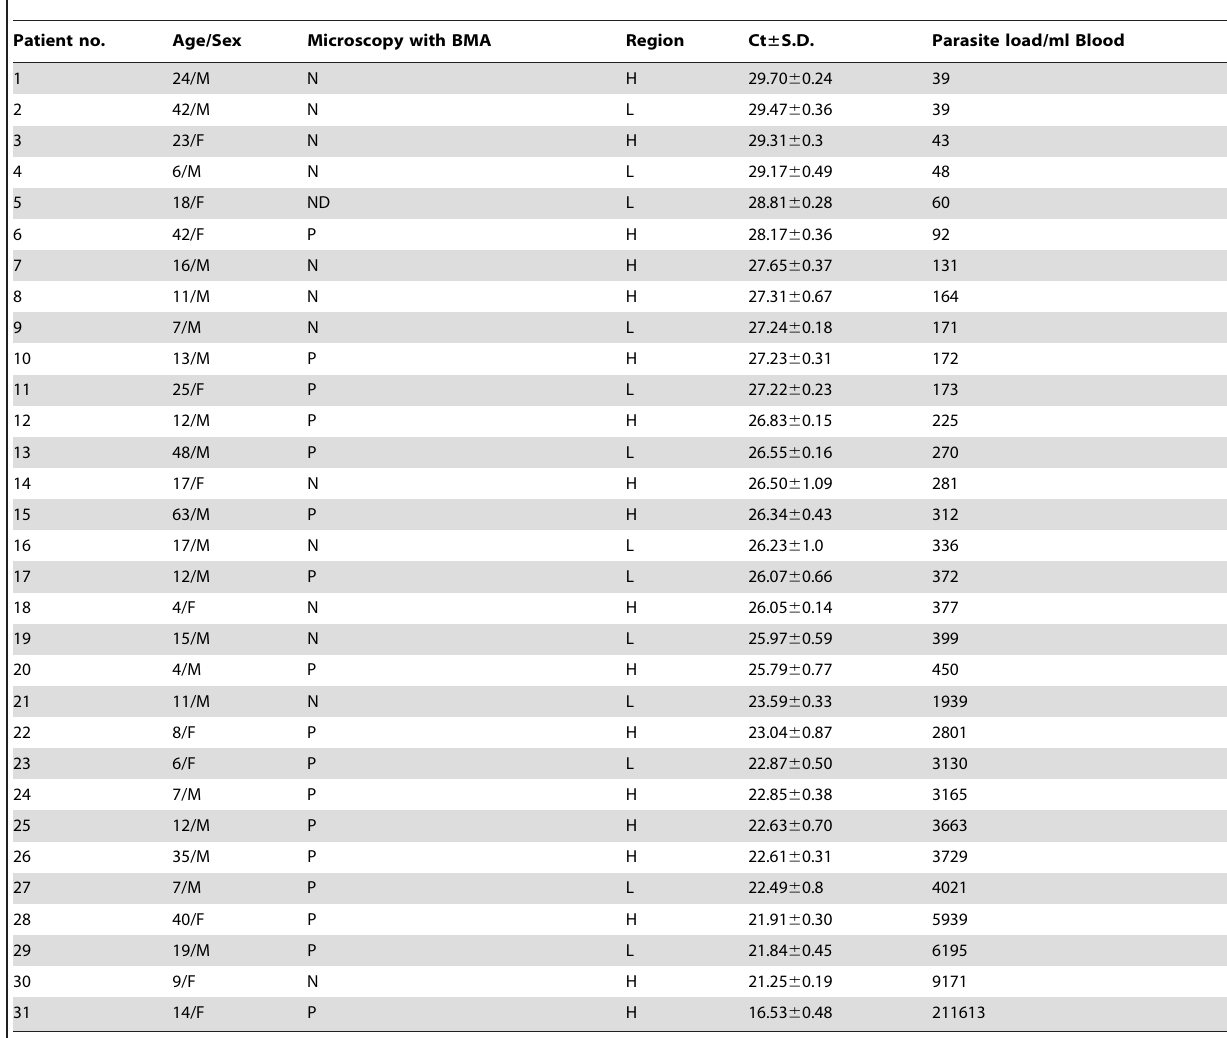
Table 1. Results of real-time PCR assay for Leishmania DNA in blood samples of VL patients.